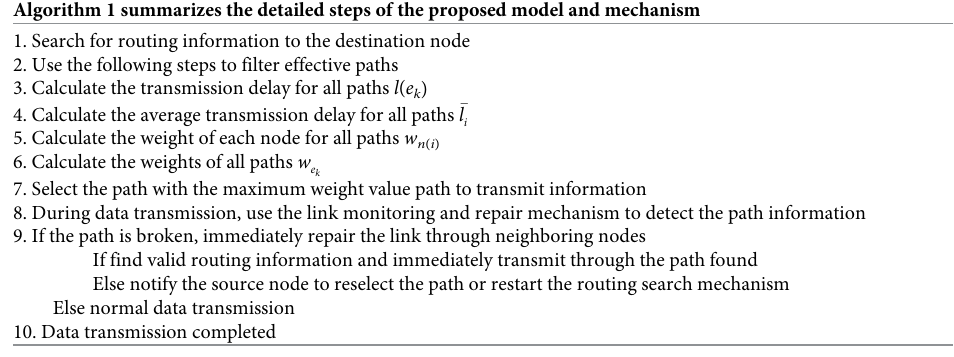
Table 1. Summary of overall algorithm.